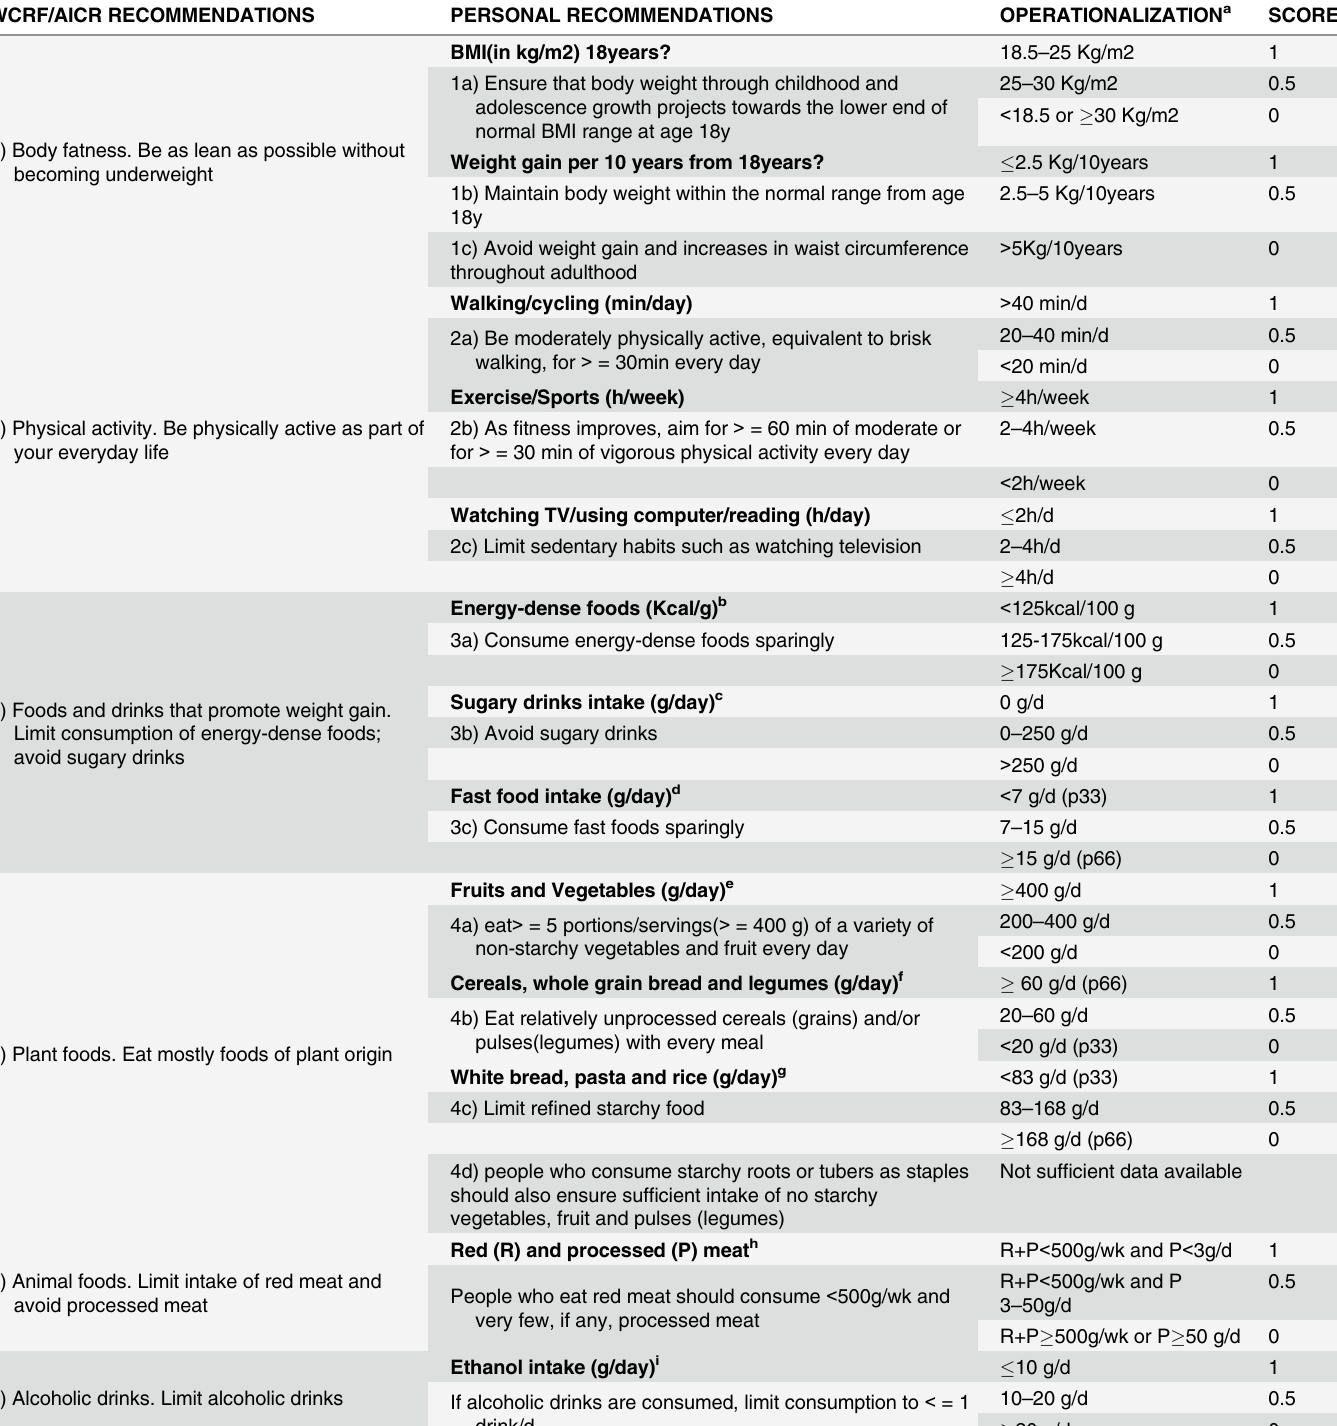
Table 1. Operationalization of the WCRF/AICR recommendations for cancer prevention in a score (0 – 8) using DDM-Spain study